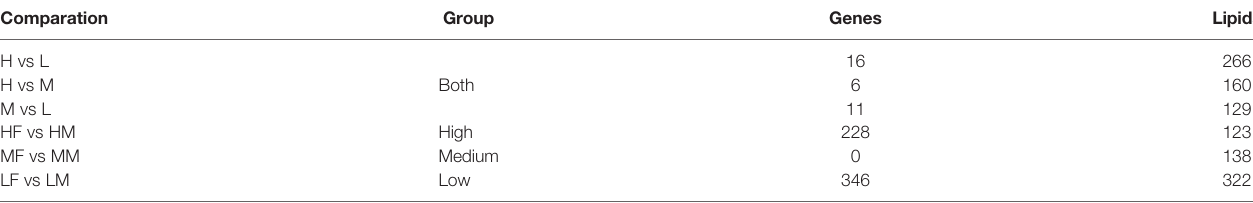
TABLE 4 | The number of differentially expressed genes and signi fi cantly changed lipid molecules in transcriptome and lipidome. Comparation